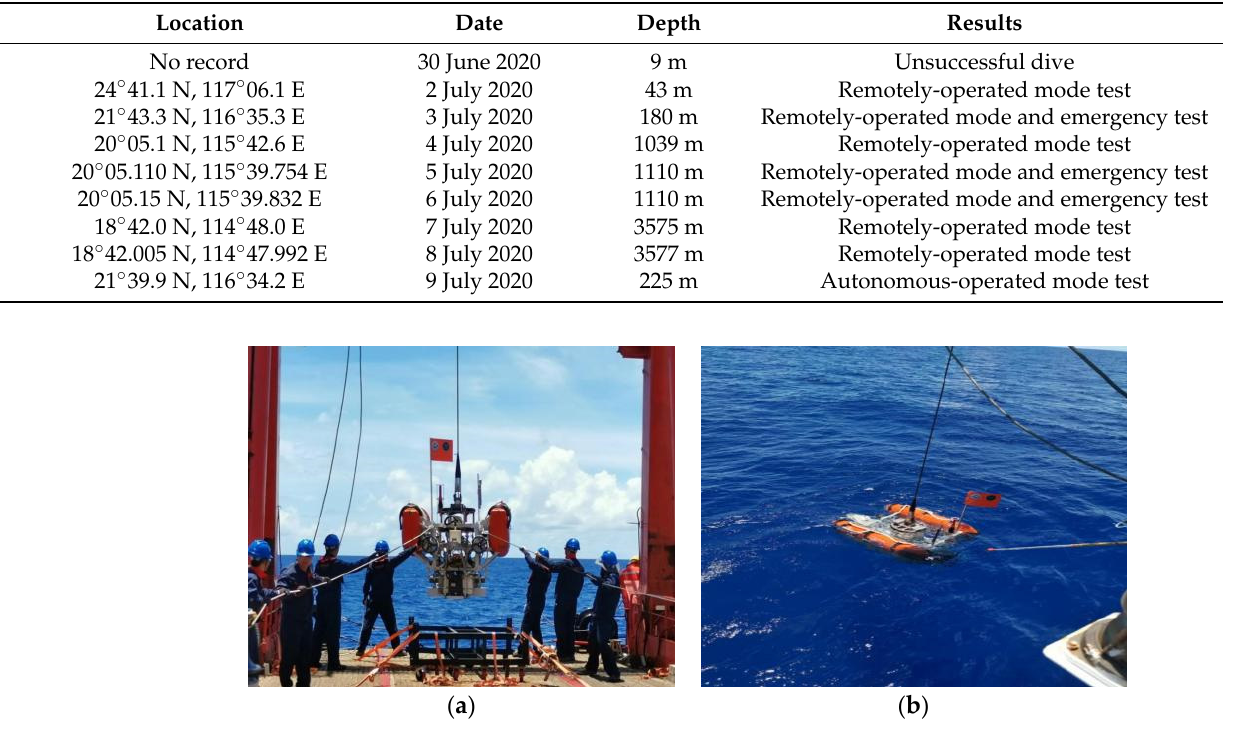
Table 10. Summary of each dive.